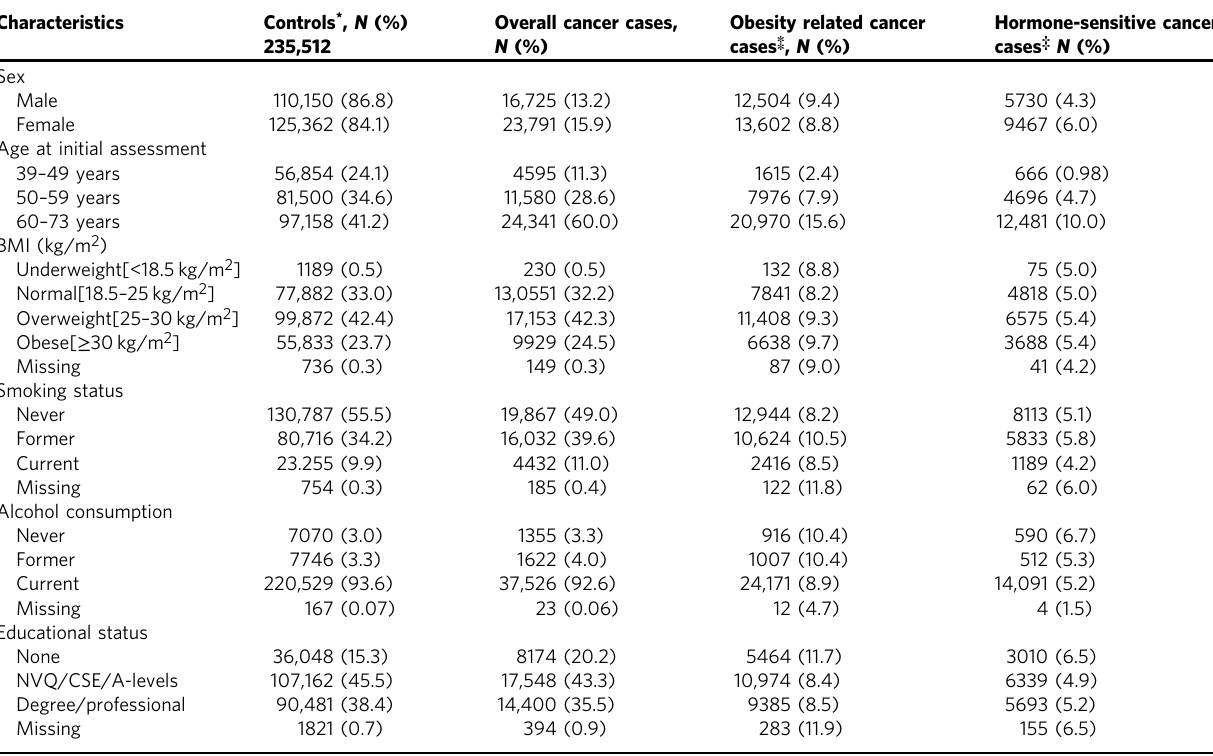
Table 1 Descriptive statistics for overall cancer, obesity-related and hormone-sensitive cancers in the UK Biobank ( N = 276,028).